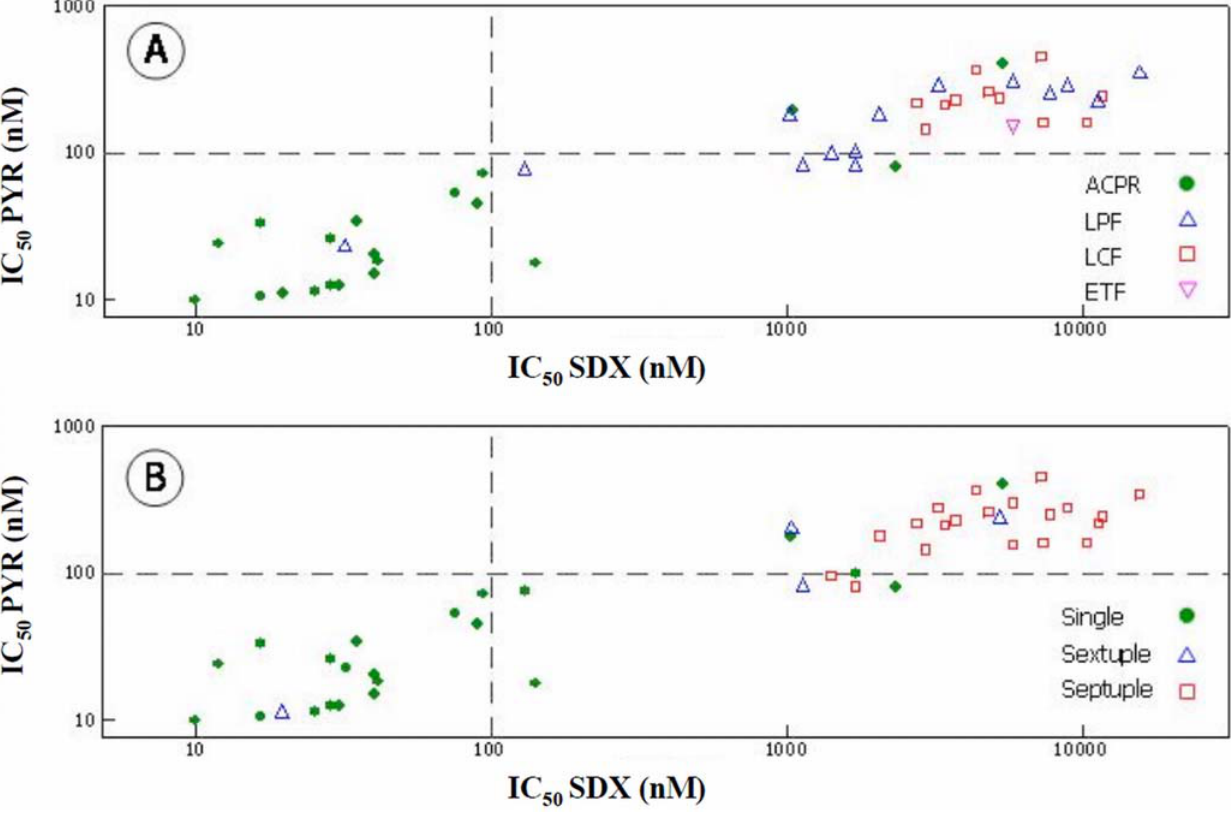
Figure 2. Invitro response (IC 50s ) of cultured adapted P.falciparum to sulfadoxine (SDX) and pyrimethamine (PYR) in relation to clinical outcomes (Panel A: ACPR N , LPF D , LCF % , ETF , ) and number of mutation in DHFR and DHPS (Panel B: single N , sextuplet D , septuplet % ).